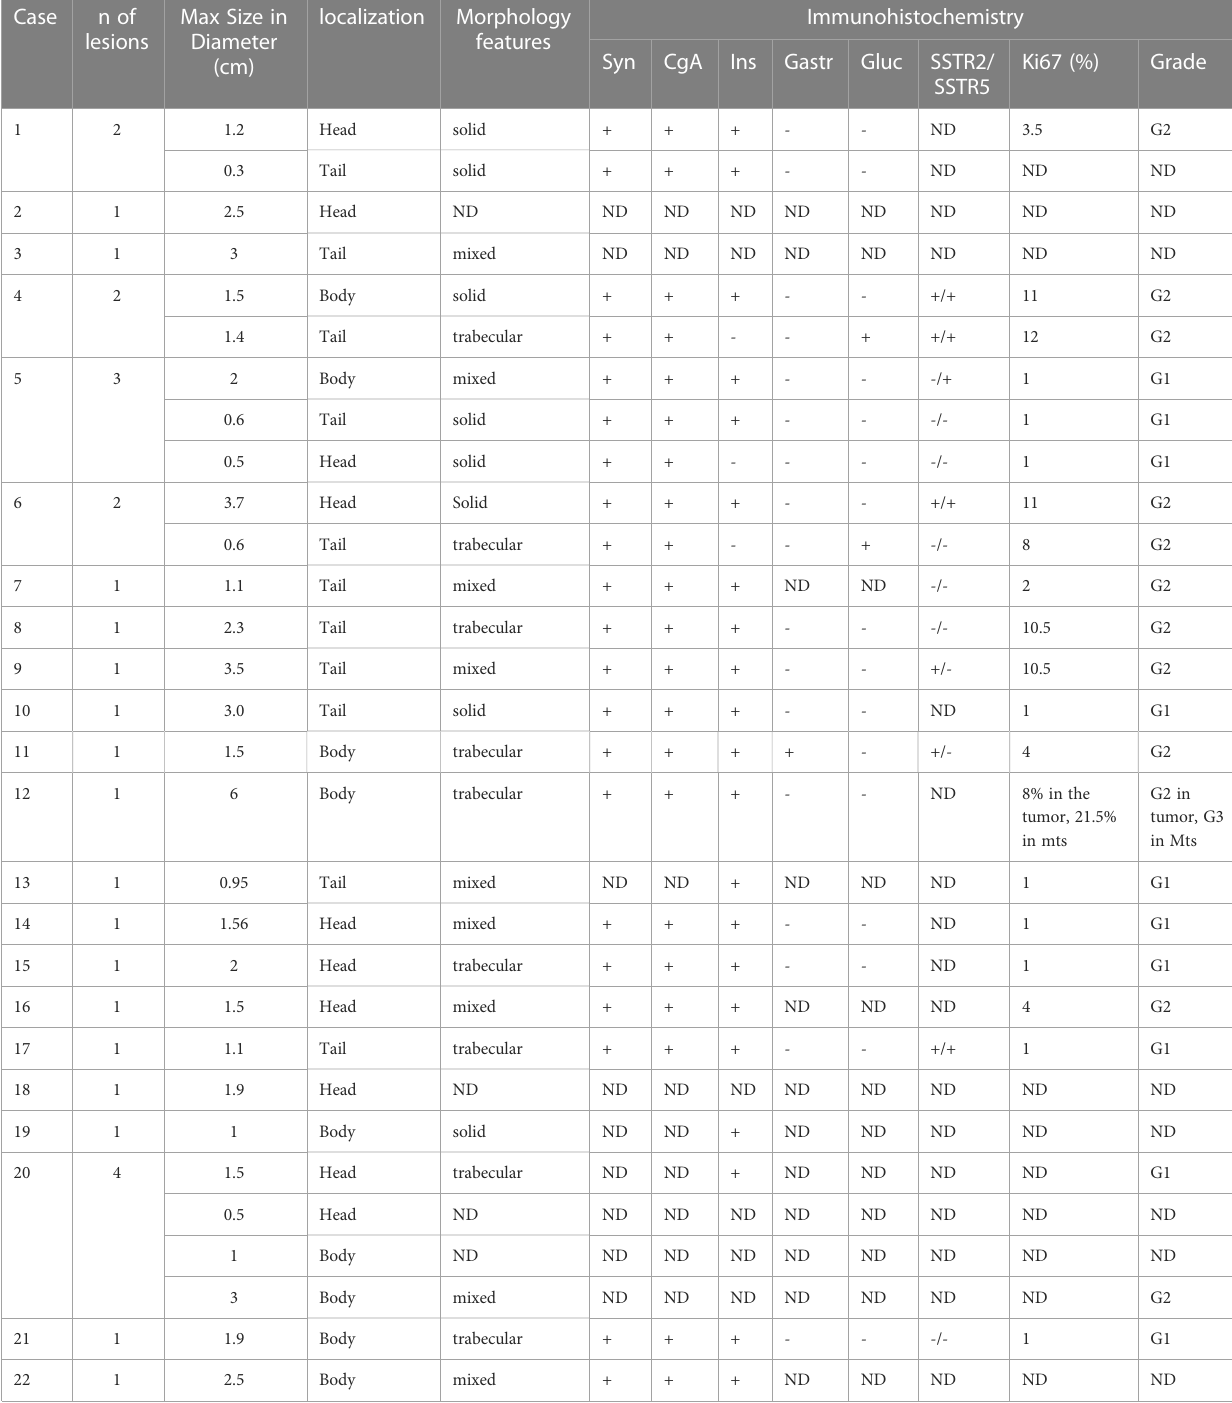
TABLE 3 Pathology results for 22 pediatric patients with resected insulinoma. Case n of